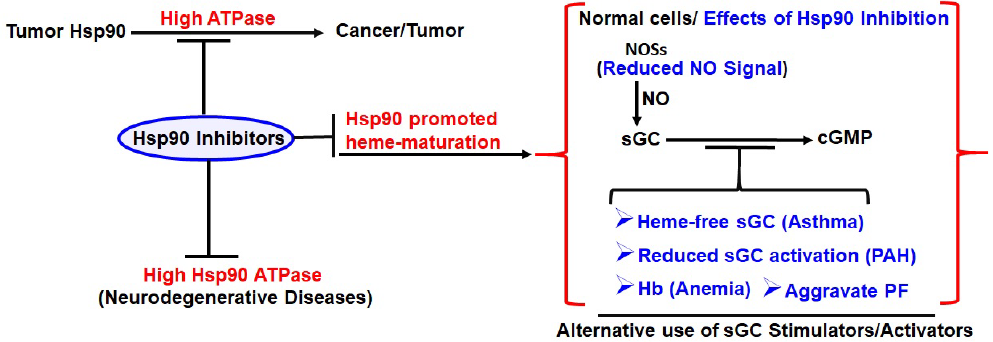
Figure 6. Representations depicting the potent effect of Hsp90 inhibitors on the high Hsp90 ATPase in cancer or neurodegenerative diseases and the adverse effects of these inhibitors in normal cells due to inhibition of heme-maturation of depicted proteins.